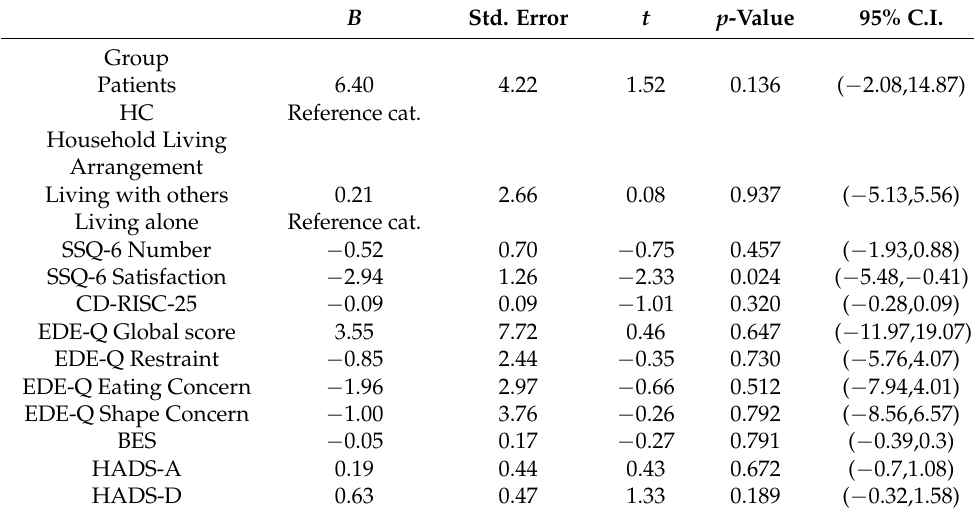
Table 5. Multiple linear regression analysis with UCLA Loneliness Scale as the dependent variable (total